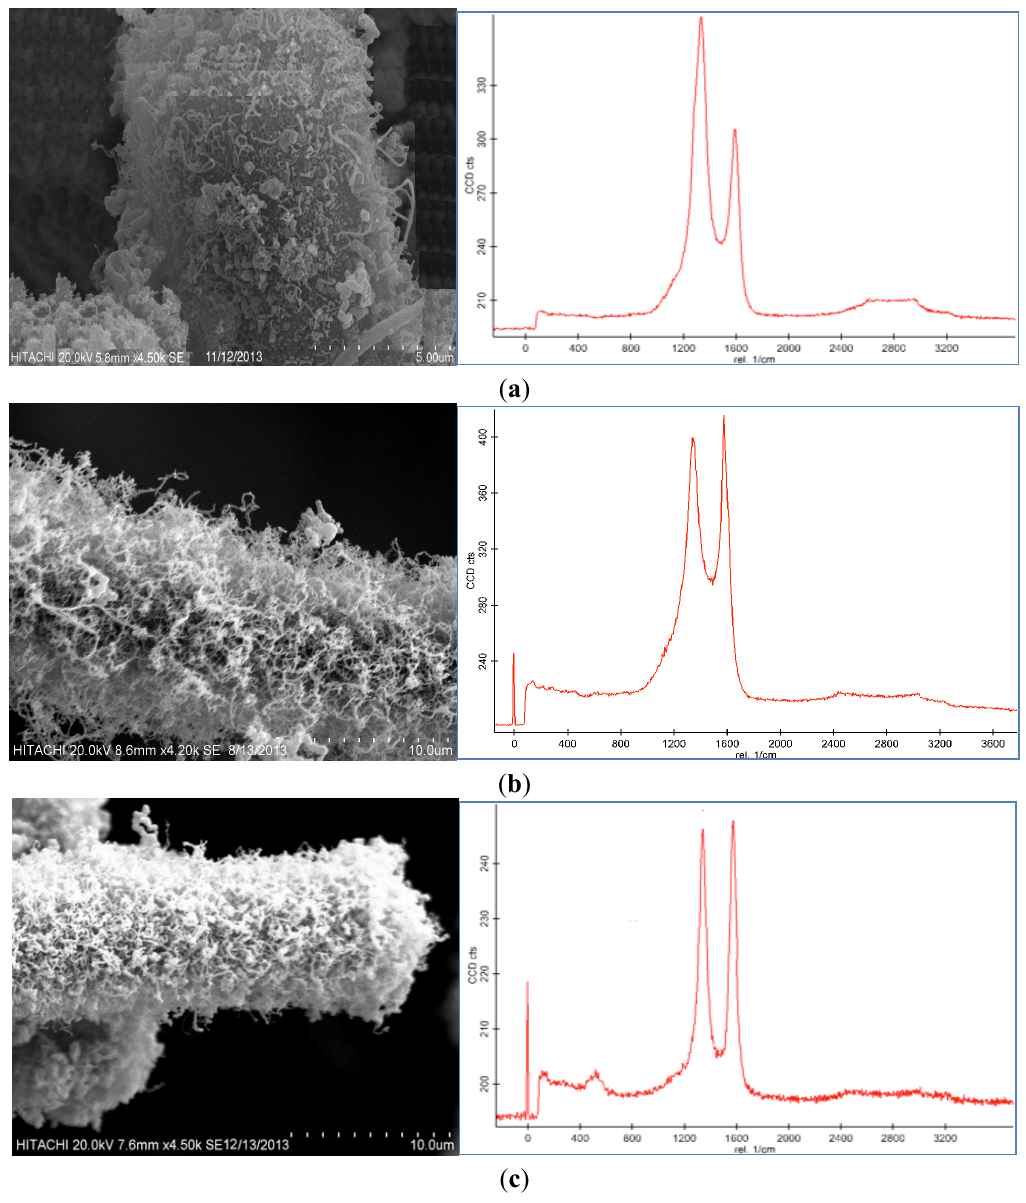
Figure 5. SEM images and Raman Spectrum of CNF morphologies at ( a ) 10 min, ( b ) 30 min, and ( c ) 50 min using 100 mM acid concentration at 550 °C under 50 sccm acetylene flow rate.